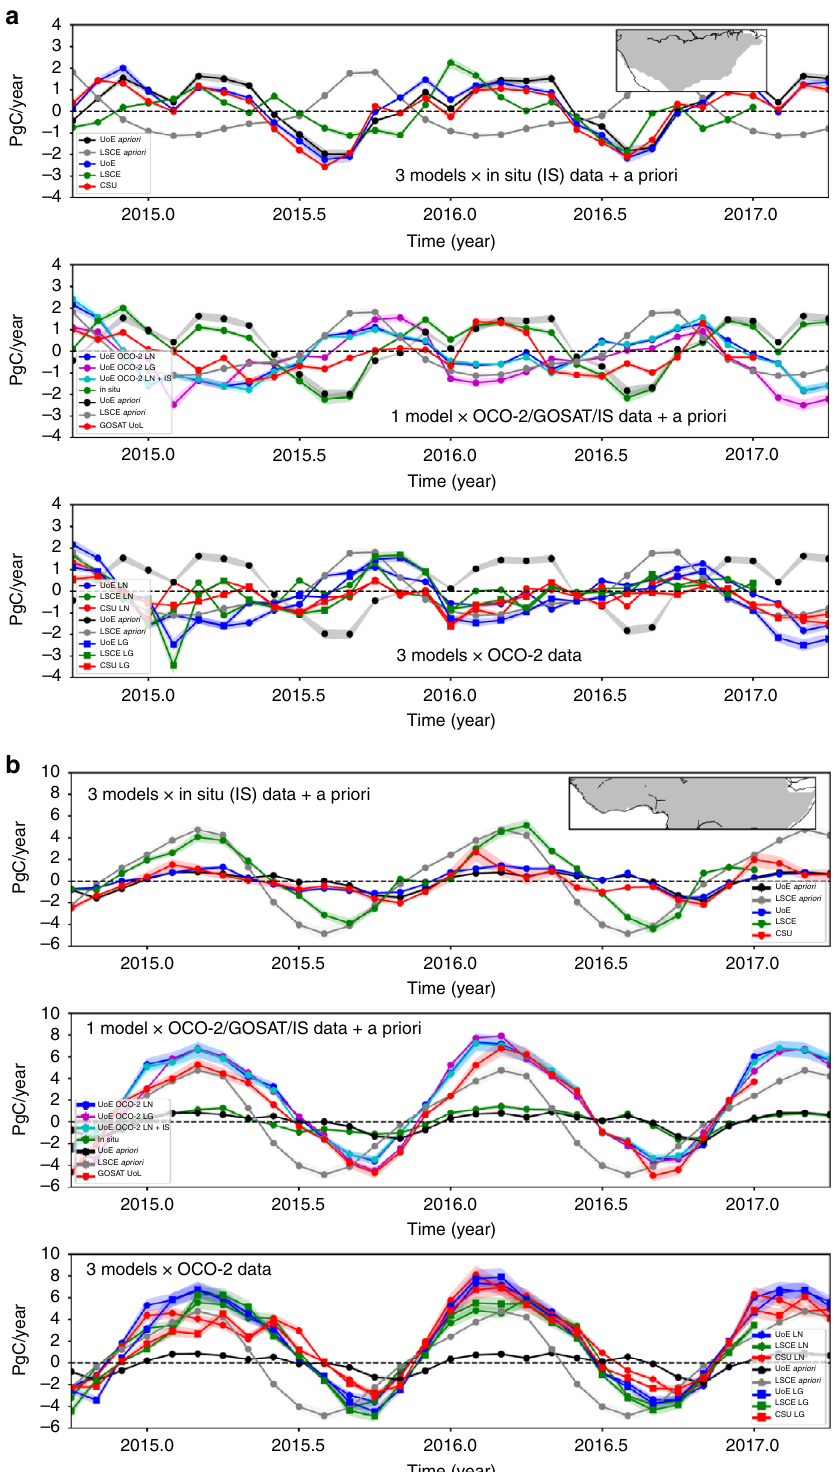
Fig. 2 CO 2 fl uxes from tropical South America and tropical northern Africa. Monthly a priori and a posteriori CO 2 fl uxes (expressed as PgC year − 1 , mid- 2014 to 2017) from a southern tropical South America and b northern tropical Africa, inferred from in situ mole fraction measurements and from GOSAT and OCO-2 satellite measurements of X CO2 . Positive fl uxes are from the land surface to the atmosphere. LN and LG denote X CO2 measurements taken from nadir and glint observing modes, respectively. The geographical regions are shown inset of each upper